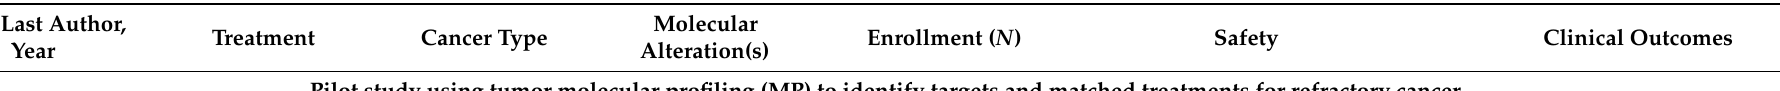
Table 1. Other selected trials in precision oncology across tumor